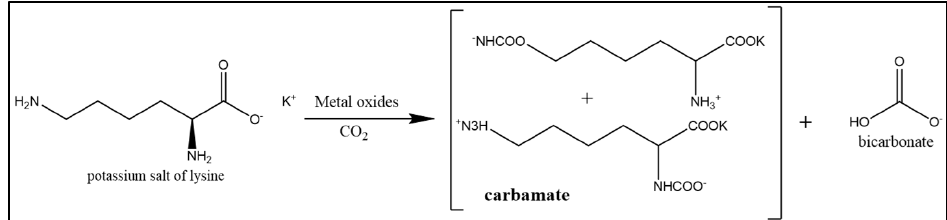
Figure 3. Structure of potassium salt of lysine(Adapted from [47] with permission from Elsevier)